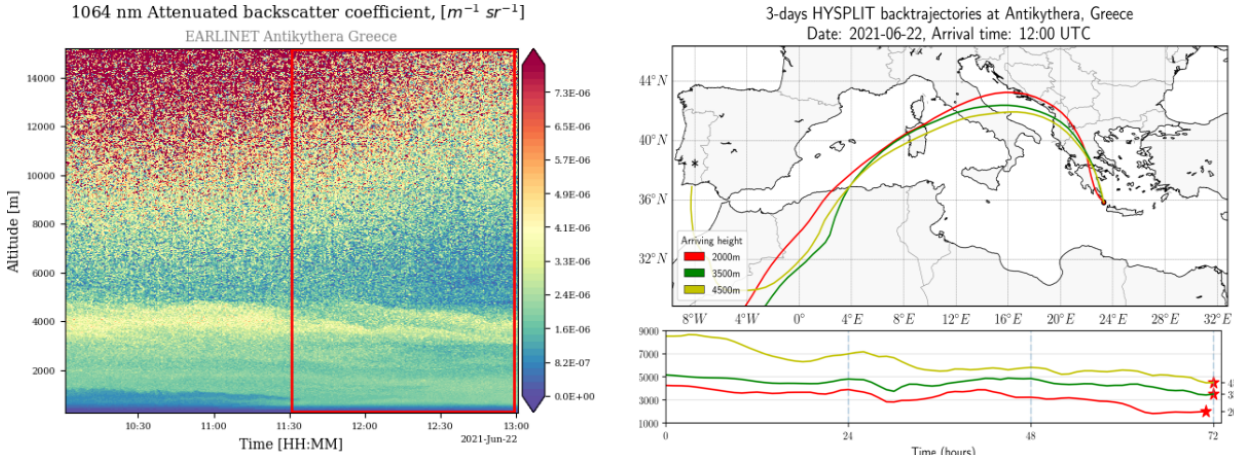
Figure 4. Temporal evolution of the total attenuated backscatter signal from the PANGEA Polly XT at 1064nm (left) and 3d back trajectories arriving at Antikythera, Greece, on 22 June 2021 at 12:00UTC (right, HYSPLIT accessible at https://www.ready.noaa.gov, last access: 2 June 2022).